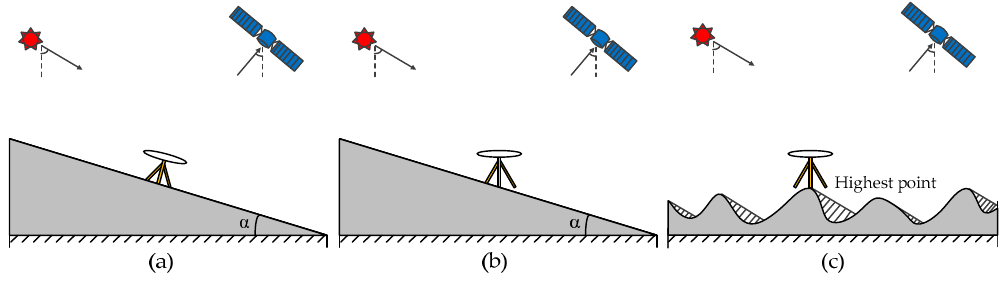
Figure 5. Reference plane configuration over solo slope (( a ) slope-parallel white plane and ( b ) horizontal reference plane) and composite slope (( c ) horizontal reference plane at the highest point).